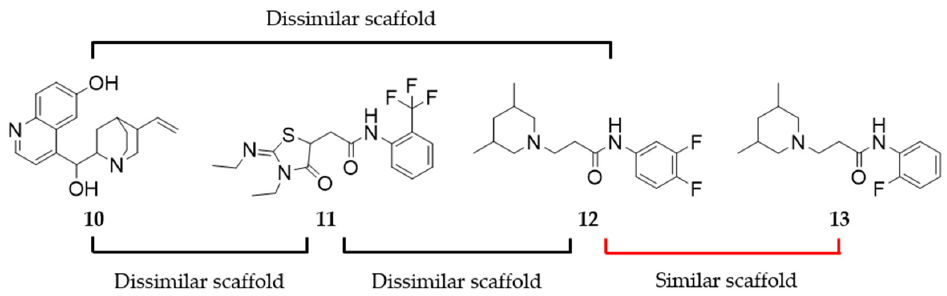
Figure 6. Exemplary assessment of scaffold similarity of consensus hits (n = 3).